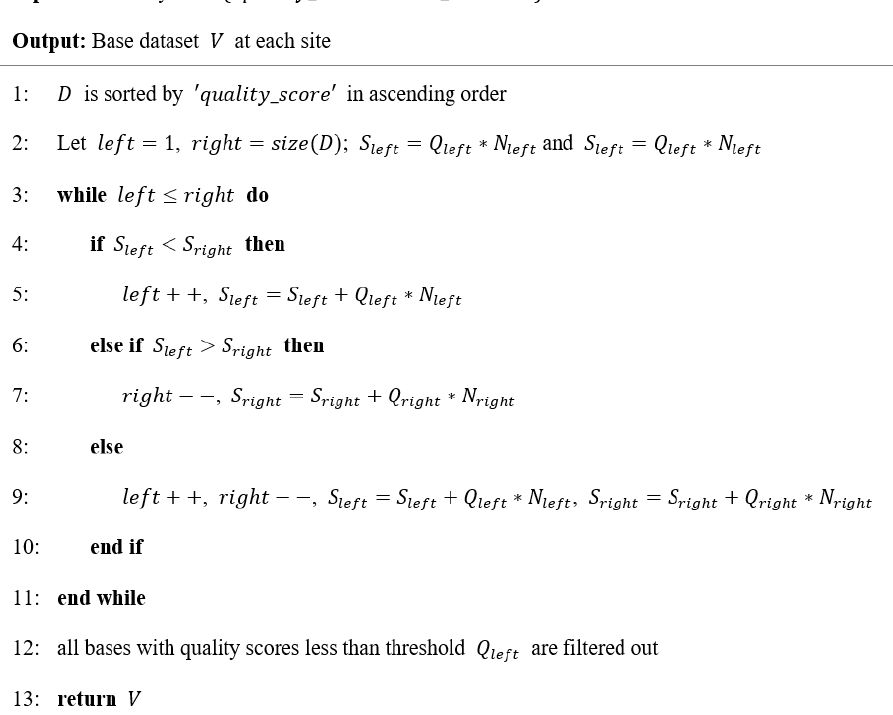
Figure 2. The pseudo code of nucleobase filtering algorithm with dynamic threshold. Here, D represents the dictionary which stores ‘ quality _ scores (cid:48) : base _ numbers pairs at each site; V represents the base dataset after filtering by the algorithm at each site; Q represents the base quality score corresponding to left or right; N represents the base number corresponding to Q left or Q right . We implement the algorithm for the mapped sequencing reads at each site of the reference genome to obtain the high-quality sequence data for mutation spectra